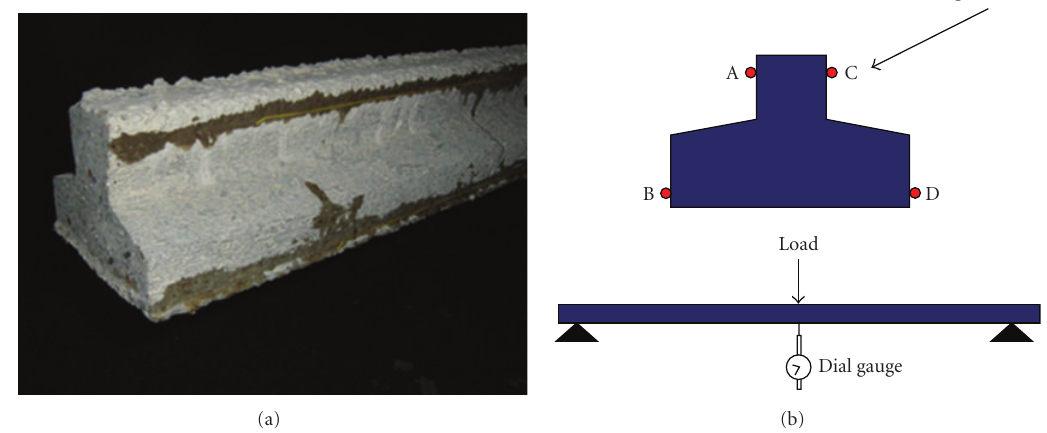
Figure 2: (a) Picture of the concrete beam used for the tests; (b) the crosssection and longitudinal view of the concrete beam used for the tests.